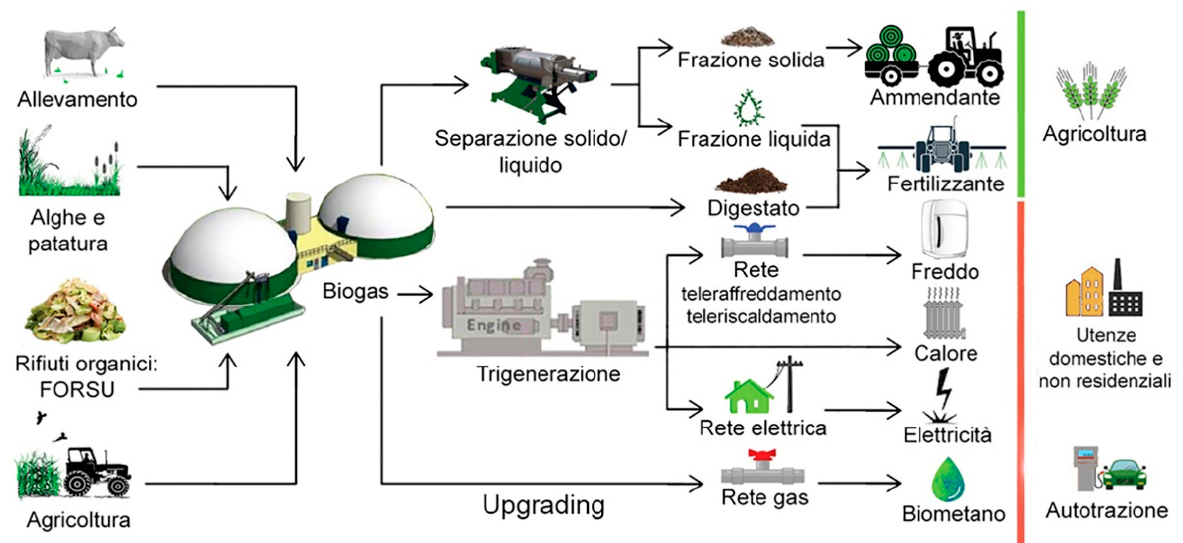
Figure 10. Operation diagram of the co-trigeneration plant fueled by biogas. (Source: Degree thesis by Agnese Ricciardelli. A.A. 2018–2019. Thesis supervisor F. Crupi).